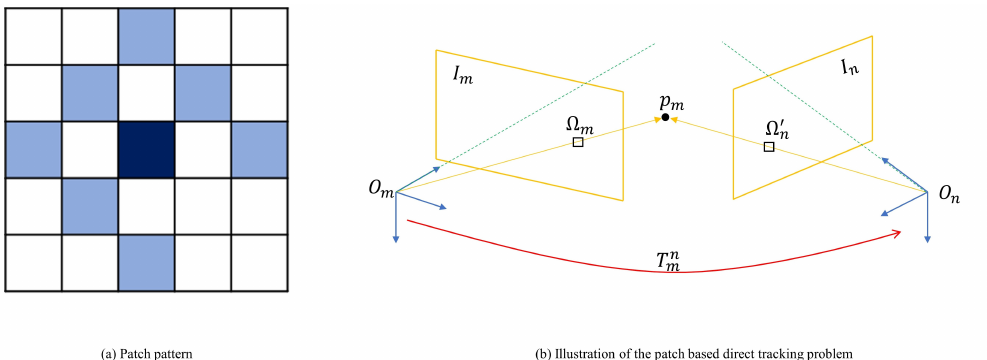
Figure 3. ( a ) The patch pattern used in our approach, the colored cells are pixels used in direct tracking process, and all pixels share the same depth with the intermediate dark grid obtained from the LiDAR points. ( b ) Illustration of the patch based direct tracking